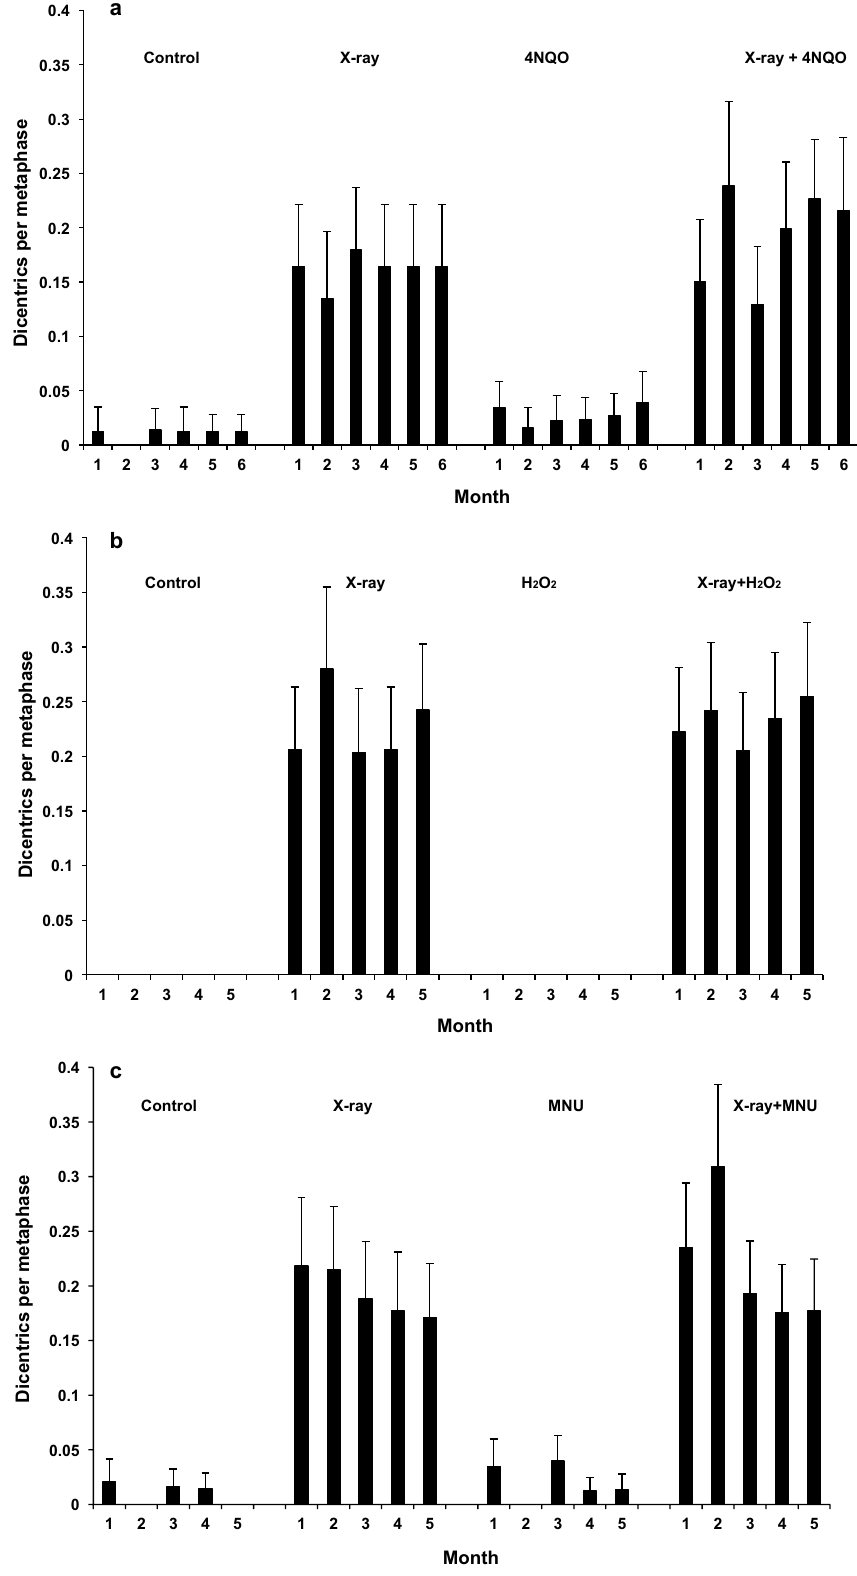
Figure 5. Dicentrics per diploid metaphase after 1–6 months of chronic exposure to: 20 ng/ml 4NQO or sham- exposure and/or acute exposure to 1 Gy X-rays ( a ); 10 μM H 2 O 2 or sham-exposure and/or acute exposure to 1 Gy X-rays ( b ); 0.25 μg/ml MNU or sham-exposure and/or acute exposure to 1 Gy X-rays ( c ). Error bars are Poisson